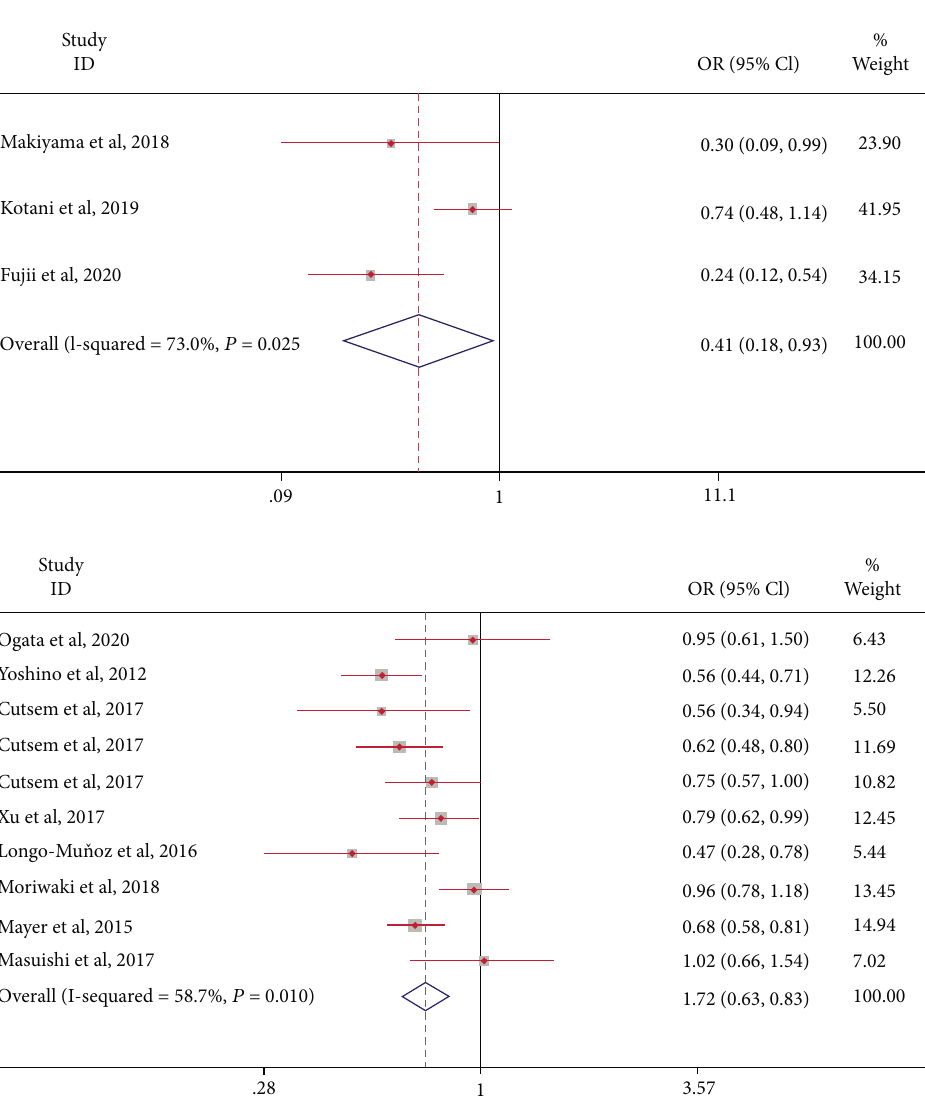
Figure 6: The odds ratio of mOS treated with combination therapy with bevacizumab or TAS-102 monotherapy as the experiment